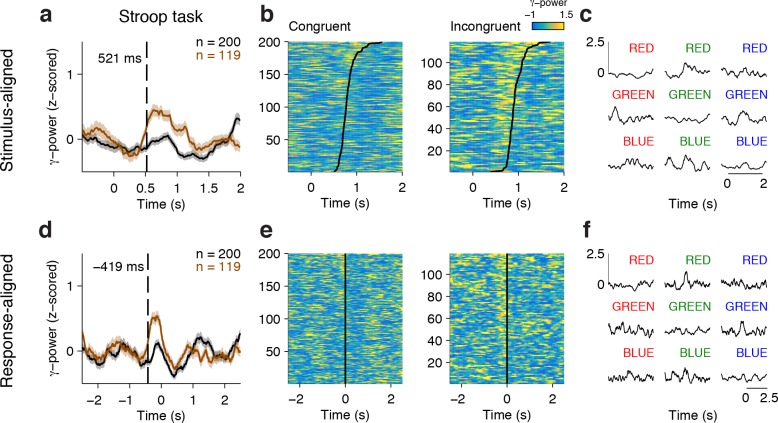
Example conflict-selective electrode in the right dorsolateral Prefrontal Cortex.Here we show a different conflict selective electrode, located in the dlPFC (format as in Figure 2).